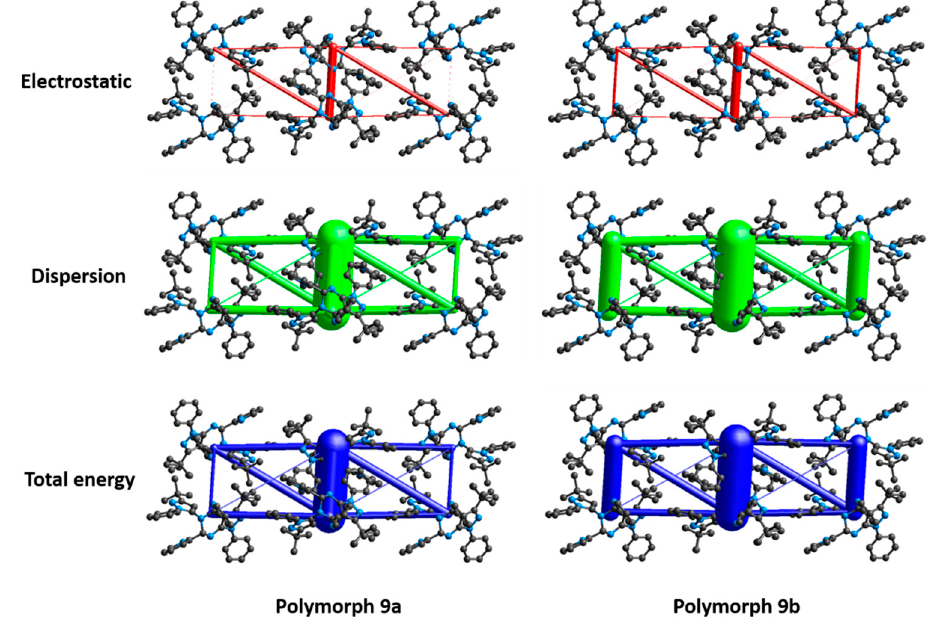
Figure 14. Energy framework diagrams for E elec , E dis , E Total for cluster of molecules in crystalline packing of 9a and 9b polymorphs. H atoms have been omitted for clarity and all diagrams used the same cylinder scale of 150 for energies.